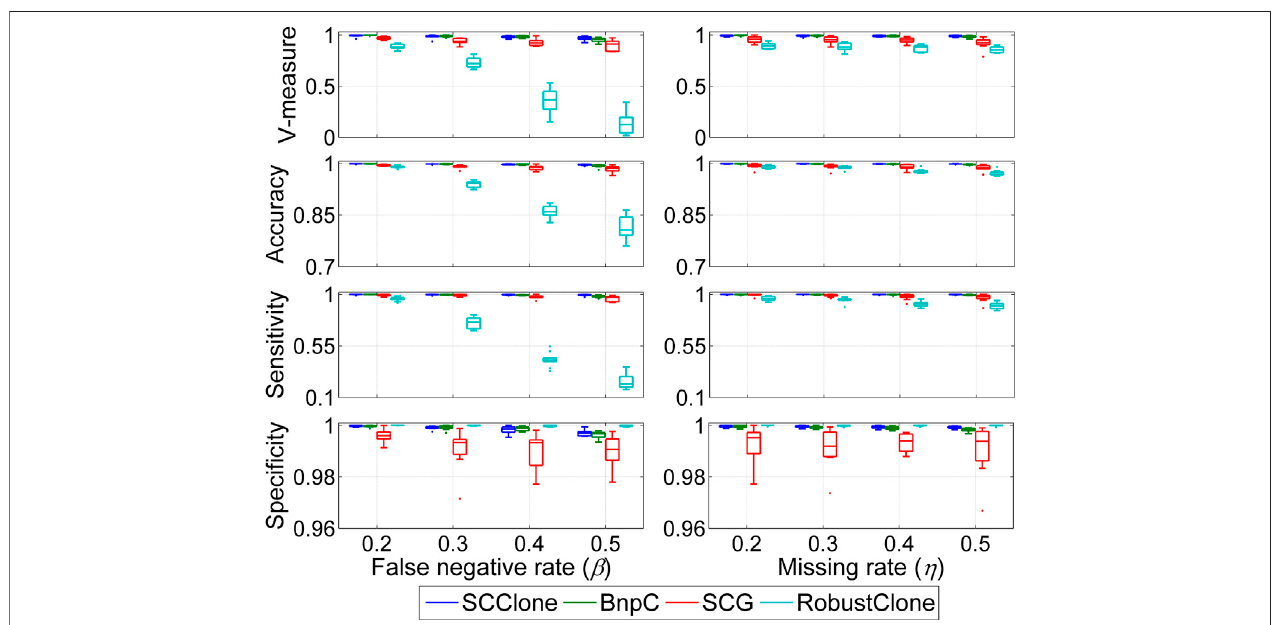
FIGURE2 | Performance evaluationresults on the simulated datasets D1 and D2. The dataset D1 consists of 500× 200genotype matriceswith the false negative rate changing from 0.2 to 0.5, and dataset D2 is constituted by 500 × 200 genotype matrices with the missing rate ranging from 0.2 to 0.5. Four performance metrics including V-measure, accuracy, sensitivity, and speci fi city are measured to examine the effects of false-negative errors and missing entries on inference